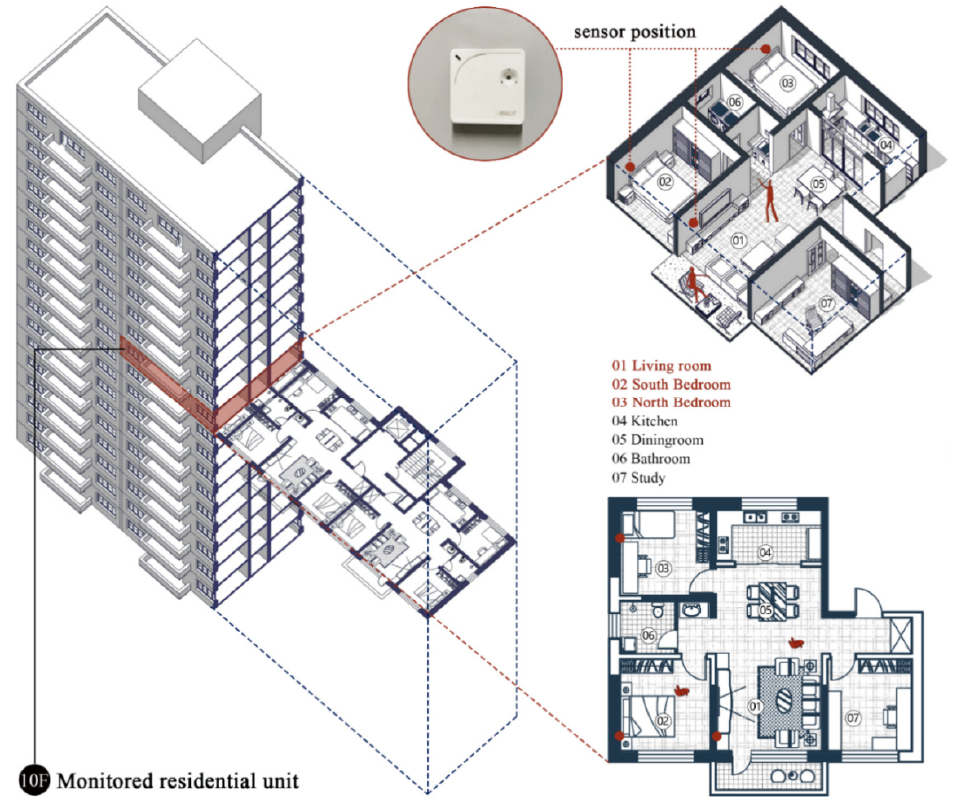
Figure 4. Details of the architectural design.